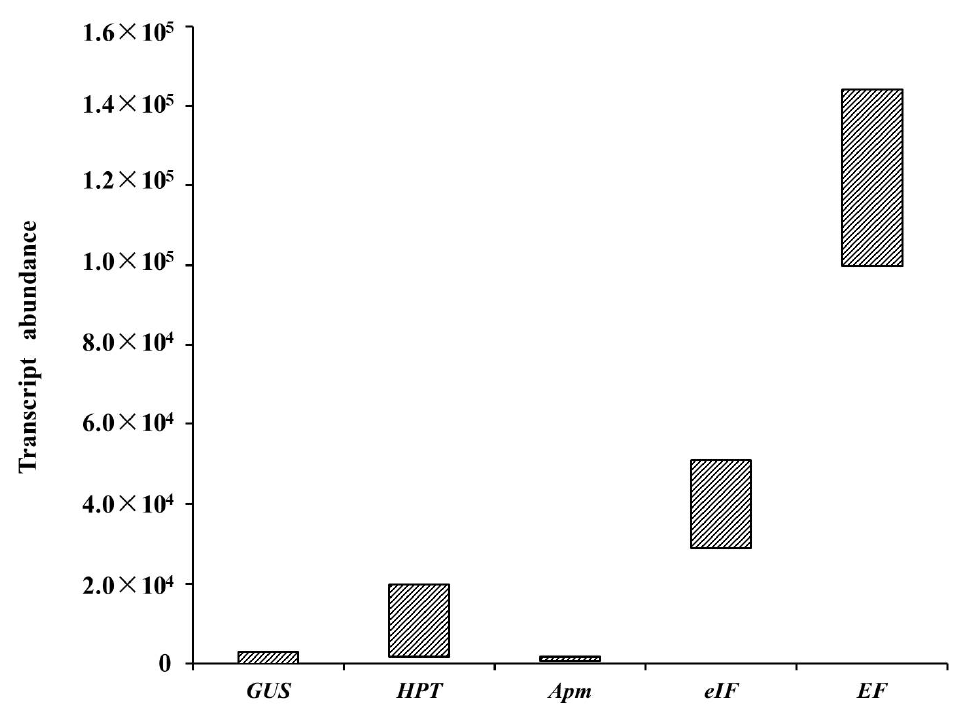
Figure 6. Schematic diagram of transcript abundance distributions of GUS , HPT , EF , eIF , and APm as assessed by qRT-PCR in stably transformed lines.